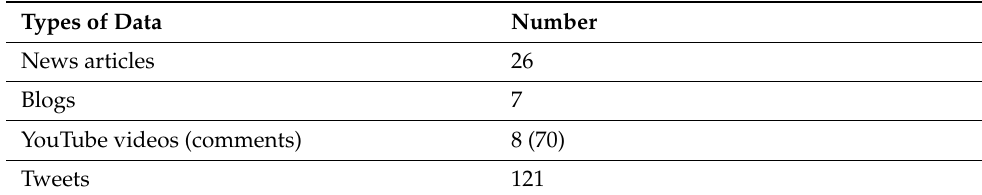
Table 1. Internet-based